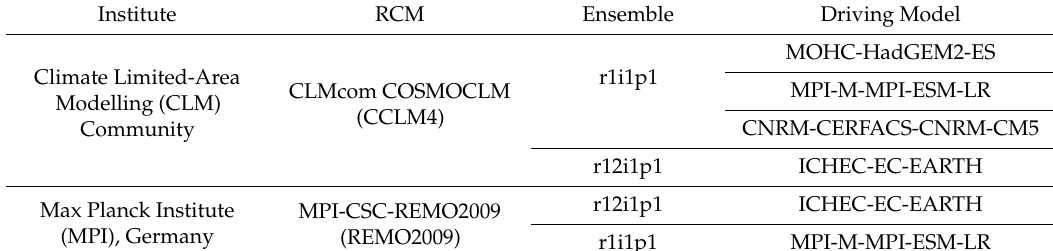
Table 1. List of regional climate models (RCMs) used in our study (data accessed in March 2020 from http: // bit.ly /